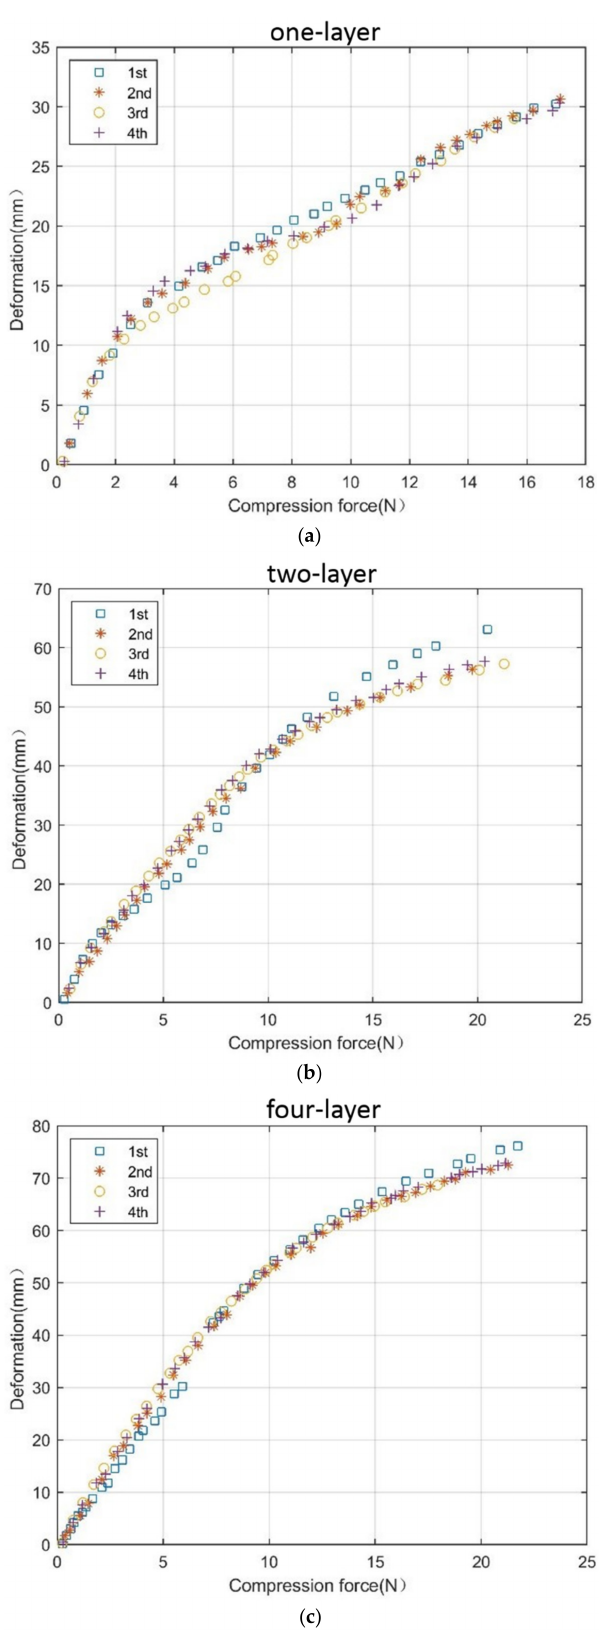
Figure 9. Experimental results of compression force vs. deformation with different layers: ( a ) one-layer; ( b ) two-layer; ( c )